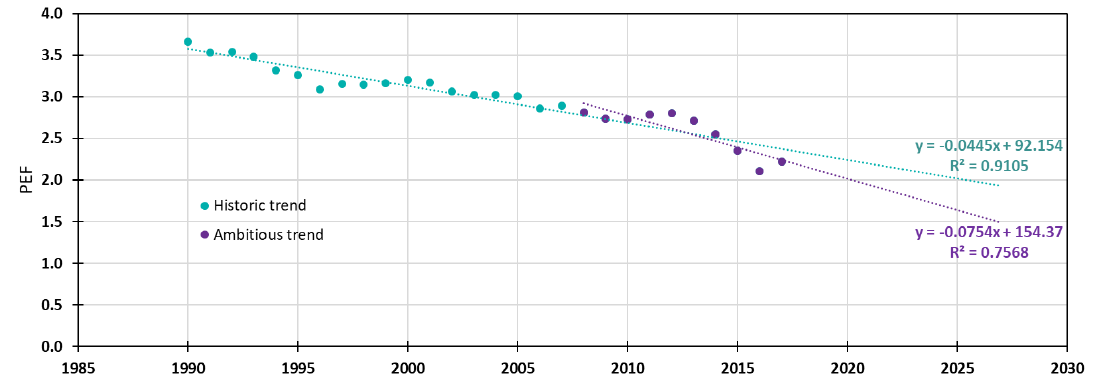
Figure 7. Time evolution of total primary energy factors for electricity generation in Greece (Data source: Energy balances from [1]).